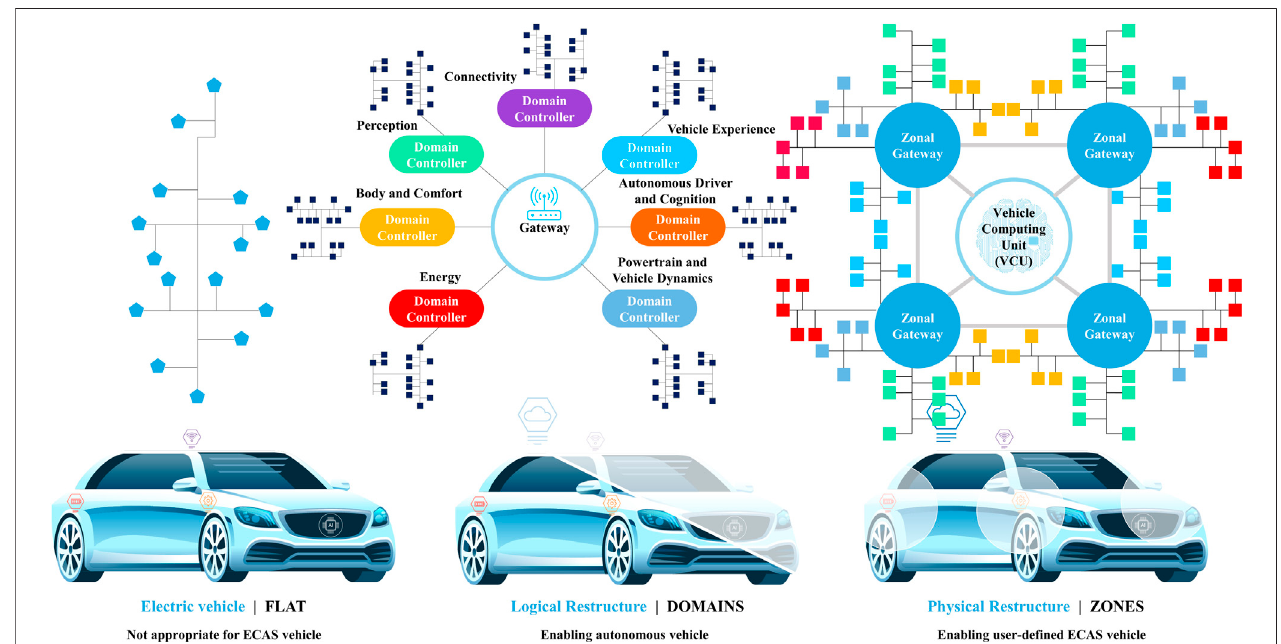
FIGURE 4 | Vehicle architecture